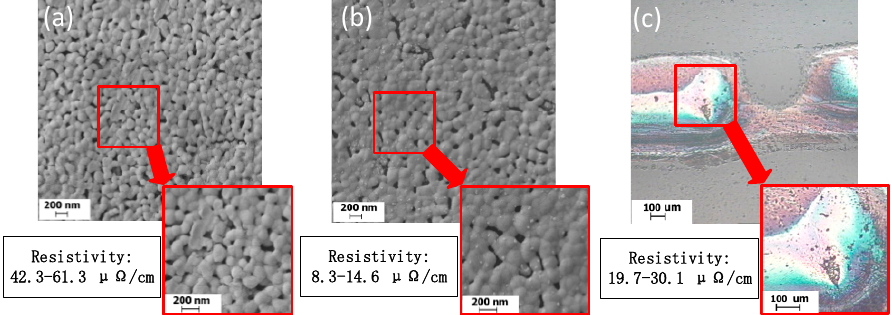
Figure 7. Field-effect scanning electron microscopy images of ( a ) incompletely sintered silver film;